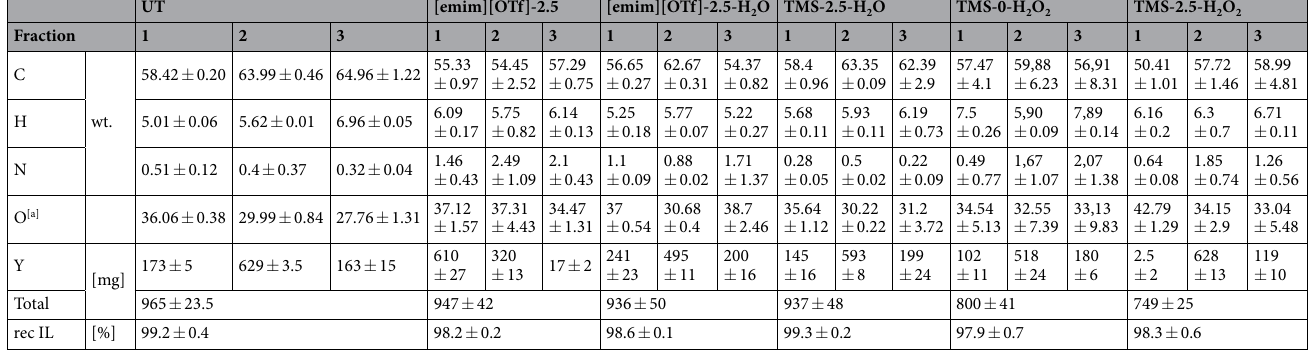
Table 2. Elemental analyses, yields (Y) and IL recovery rates (rec IL) for each electrolyte system: UT, lignin control; [emim][OTf]-2.5; [emim][OTf]-2.5-H 2 O; TMS-2.5-H 2 O; TMS-0-H 2 O 2 ; TMS-2.5-H 2 O 2 . Experiments were performed in duplicate. [a]: oxygen content was calculated as the residual w eight